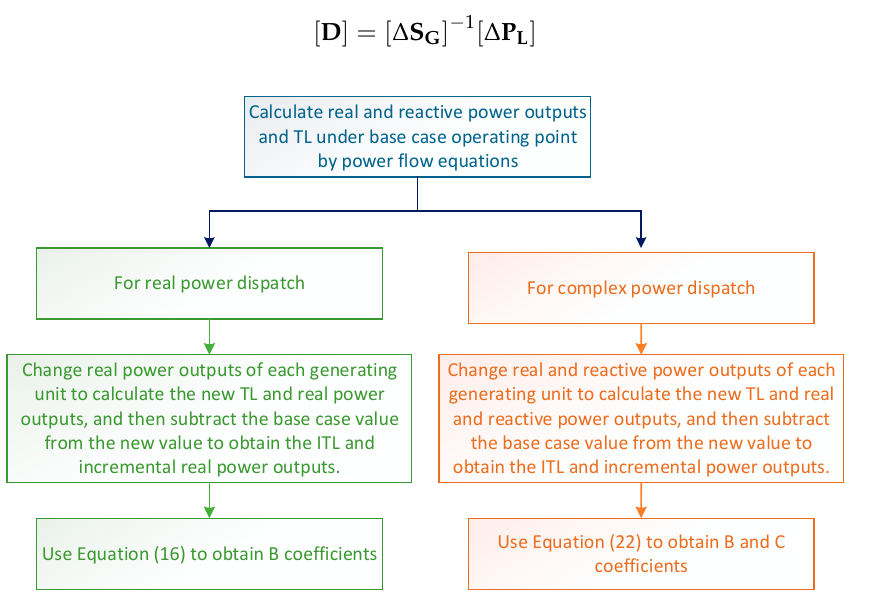
Figure 2. Computing procedure of the new loss coefficients for economic dispatch (ED). TL: transmission loss; ITL: incremental transmission